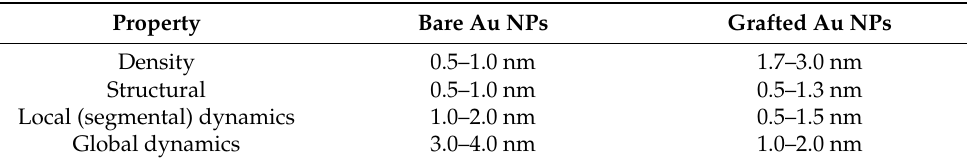
Table 2. The width of the interface in PE/au NP nanocomposites defined via different properties for the systems with 100 mers PE